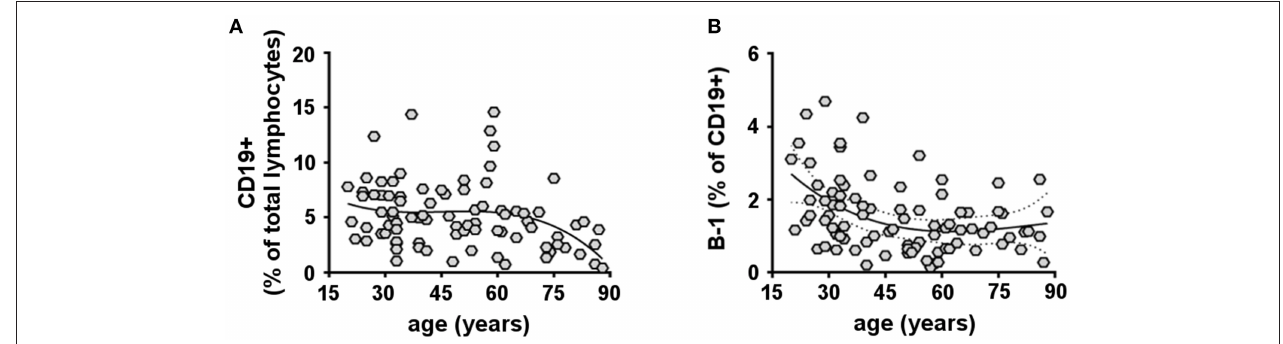
FIGURE 1 | Human B-1 cells decline with advancing age. PBMCs isolated from 87 healthy donors (20–88 years) were analyzed by flow cytometry for total CD19 + B cells (A) or B-1 cells (CD19 + CD20 + CD27 + CD38 low / int CD43 + ) (B) . (A , B) Data plotted in each diagram represent CD19 + B cells given as percent lymphocytes (A) and B-1 cells given as percent CD19 + B cells (B) , each as a function of donor age. Spearman’s r for each correlation and significance are the following: CD19 + B cells: r = − 0.2997, p = 0.0053; B-1 cells: r = − 0.3351, p = 0.0015. The solid line through the data points refers to a cubic regression curve fit.